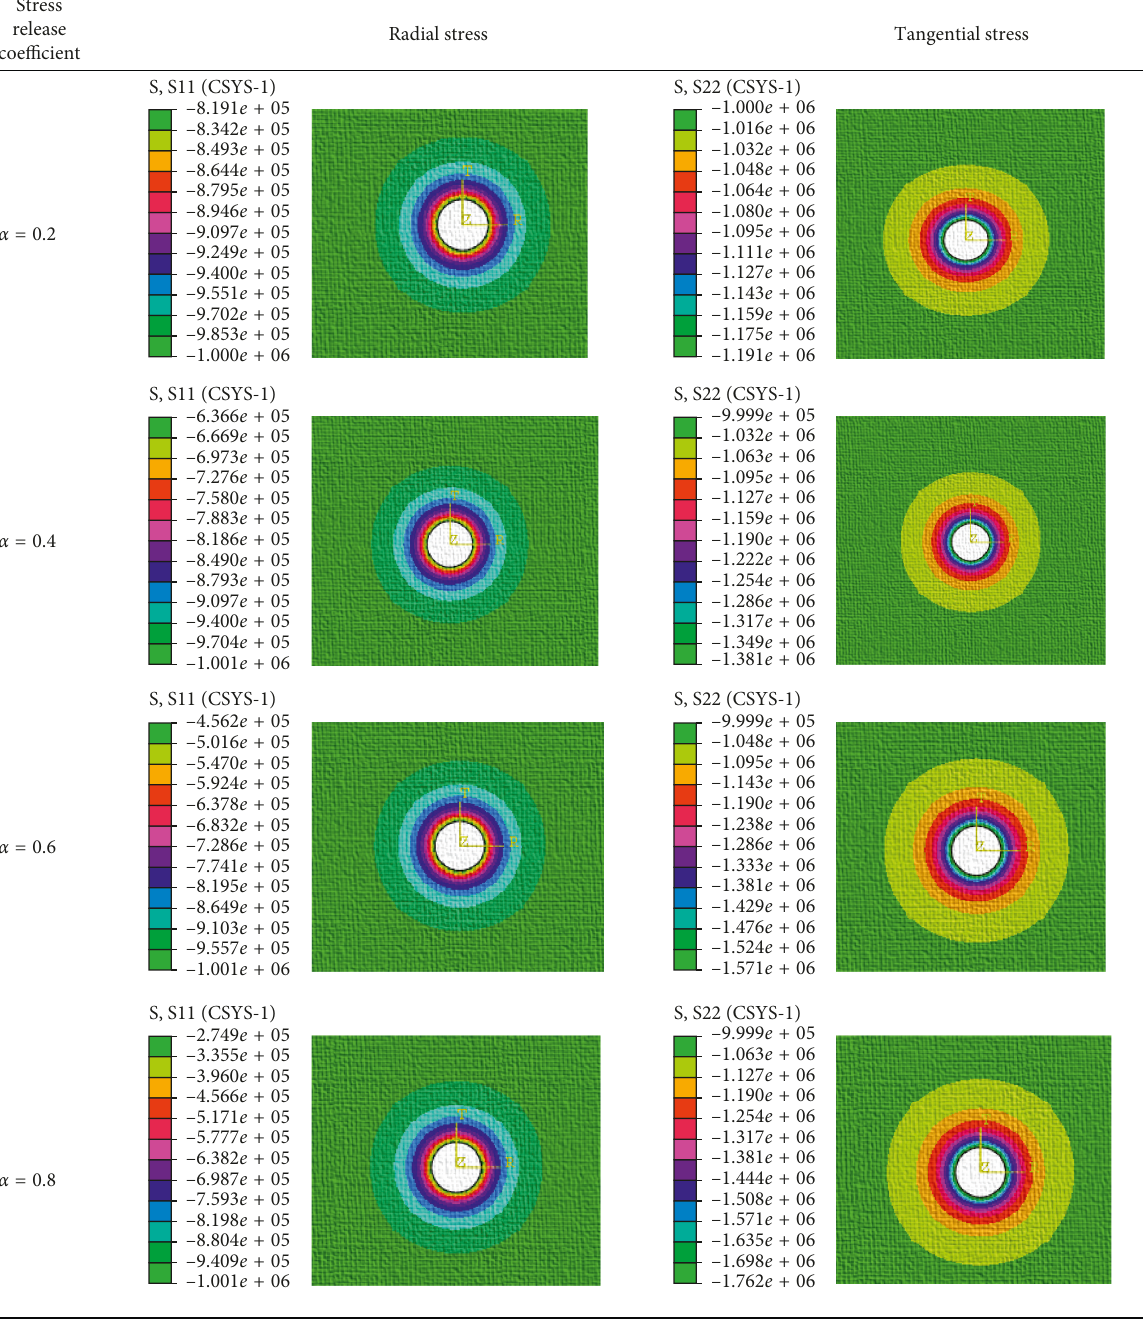
Figure 7: Contours of stress distribution of surrounding rock with different stress release